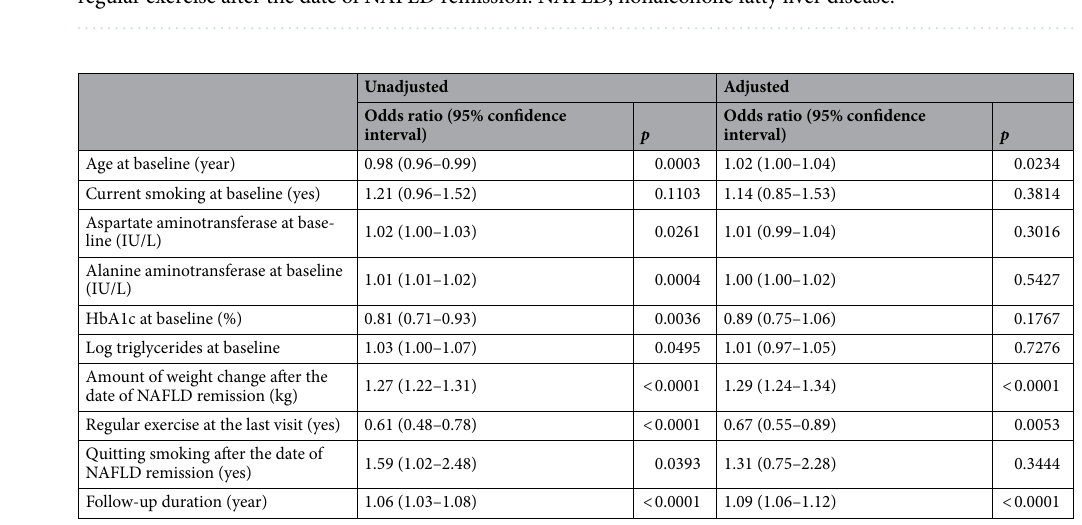
Figure 3. Changes in exercise habits. Values are presented as percentages. The p values were calculated using Pearson’s χ 2 test. ( a ) Proportions of regular exercisers during the observation period. ( b ) Proportions of participants who had newly started exercising by the date of NAFLD remission. ( c ) Proportions of participants who newly started exercising after the date of NAFLD remission. ( d ) Proportions of participants who stopped regular exercise after the date of NAFLD remission. NAFLD, nonalcoholic fatty liver disease.